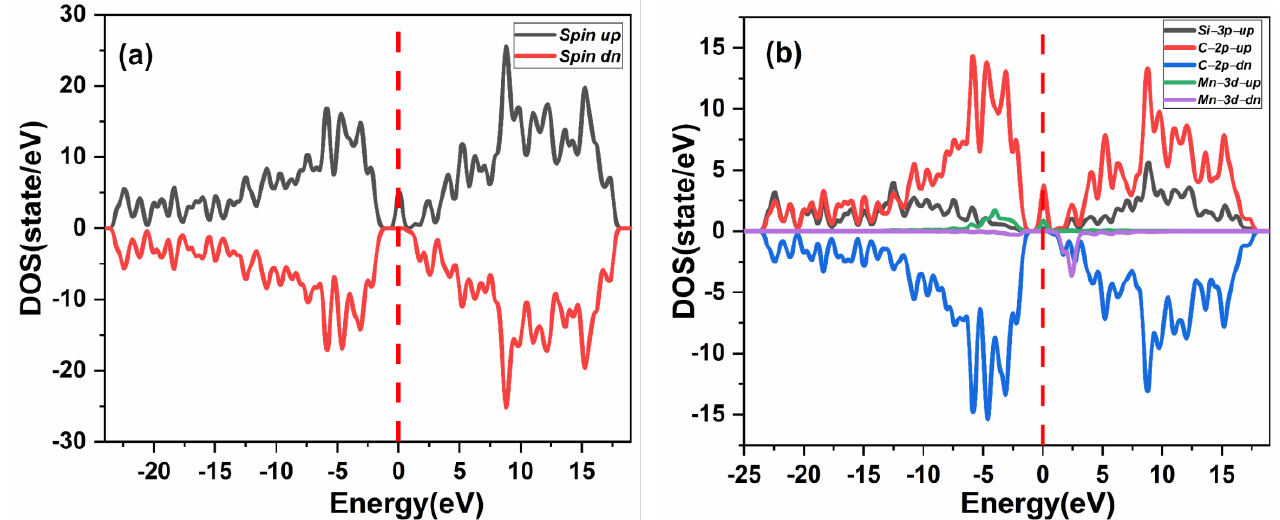
7 of 19 Figure 4. Spin polarized band structure of ( Mn +2 )-doped 3C-SiC. Fermi level denoted by a black dash line. The total density of states (TDOS) and the partial density of states (PDOS) of the Mn +2 -doped 3C-SiC compound are calculated. An asymmetry of the up and down spin channel can be seen in the TDOS, as presented in Figure 5a. This indicates that the Mn +2 dopant ion results in spin changes in the lattice of the 3C-SiC . Th p-d hybridization is re- sponsible for the asymmetry of the spin up and spin down states in the TDOS. At the Fermi level, the C- 2p states and some contribution from the Si- 2p states hybridize with